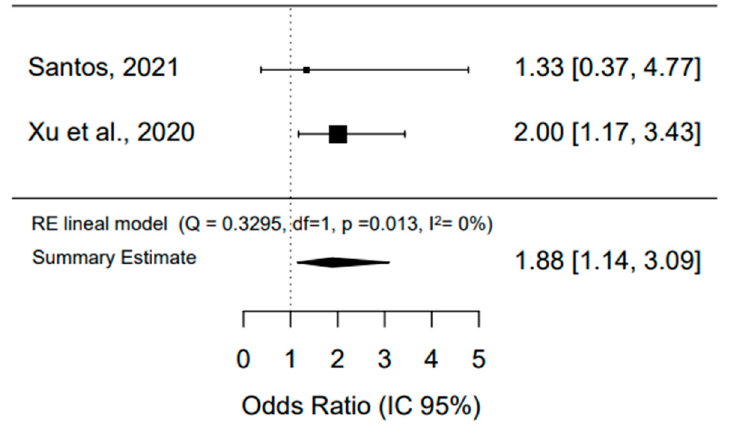
Figure 2. The association between cognitive impairment, falls, and sarcopenia in the elderly, São Paulo, SP, Brazil, 2022 [23,25].